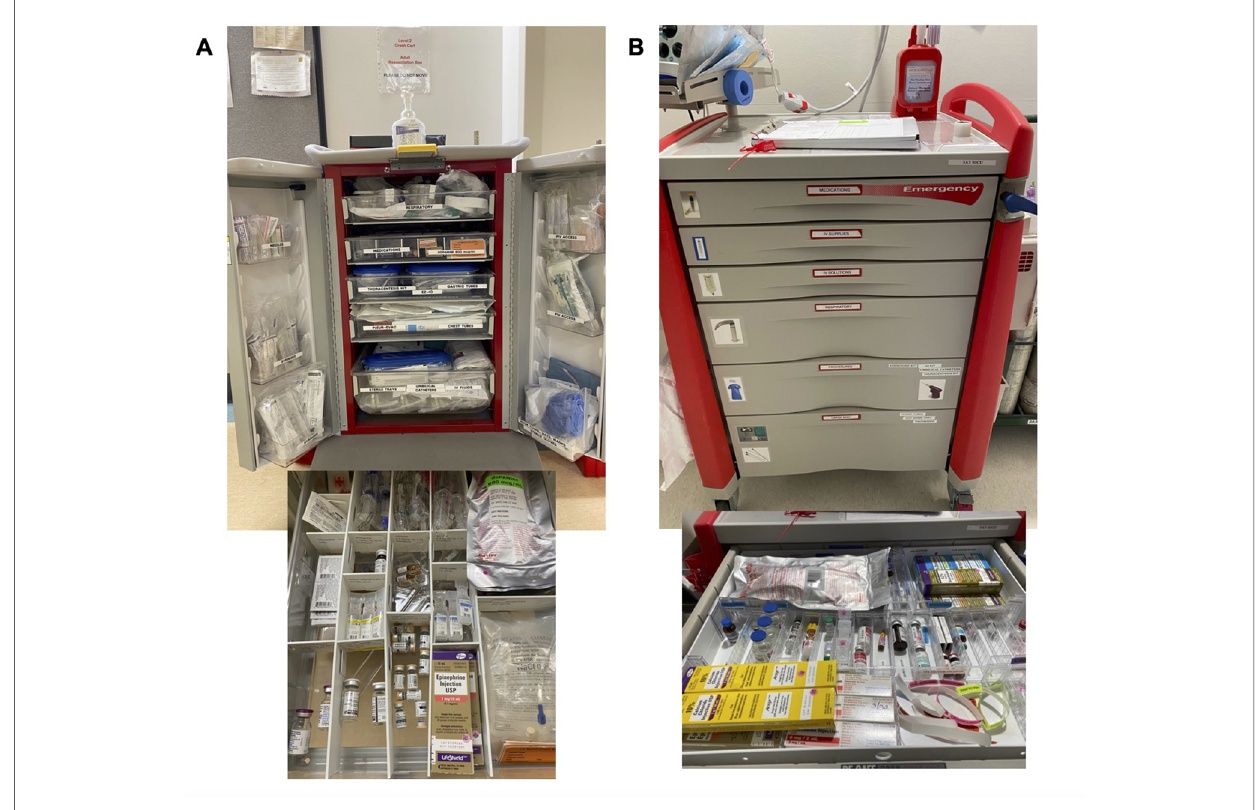
FIGURE 2 Neonatal emergency equipment carts and medication drawers for perinatal (site 1) ( A ) and surgical (site 2) ( B )